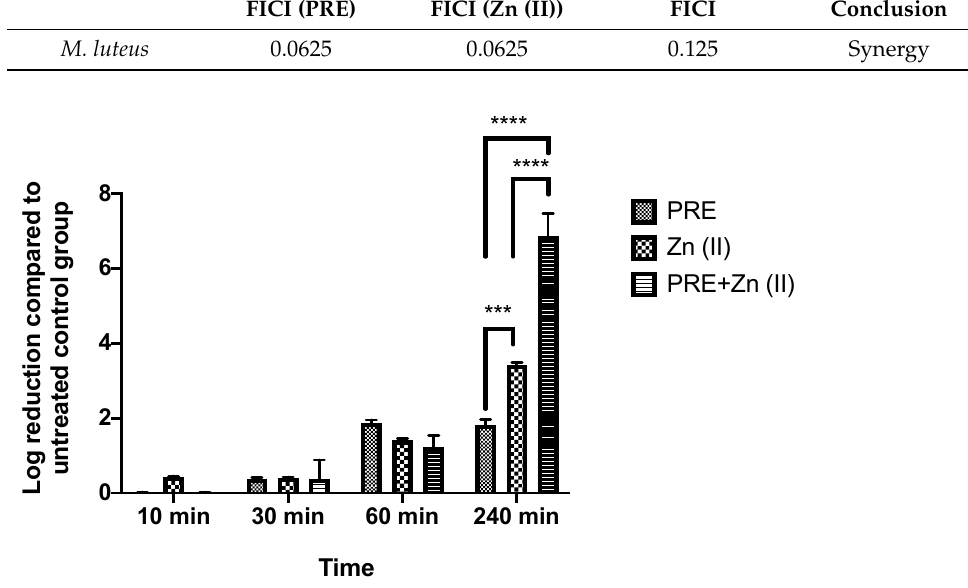
Figure 2. Log-reduction values obtained using time-kill assays for PRE (MIC/2), Zn (II) (MIC/2), and PRE/Zn (II) (MIC/2 + MIC/2) in combination against M. luteus . All data are represented as mean ± SEM ( n = 3). Note: synergistic activity at 240 min, showing a 6.88 ± 1.02 log reduction for PRE/Zn (II), which was significantly greater than the 1.83 ± 0.24 log reduction for PRE and the 3.4 ± 0.08 log reduction for Zn (II); statistical significance indicated at *** p < 0.001 and **** p < 0.0001 between treatment groups.